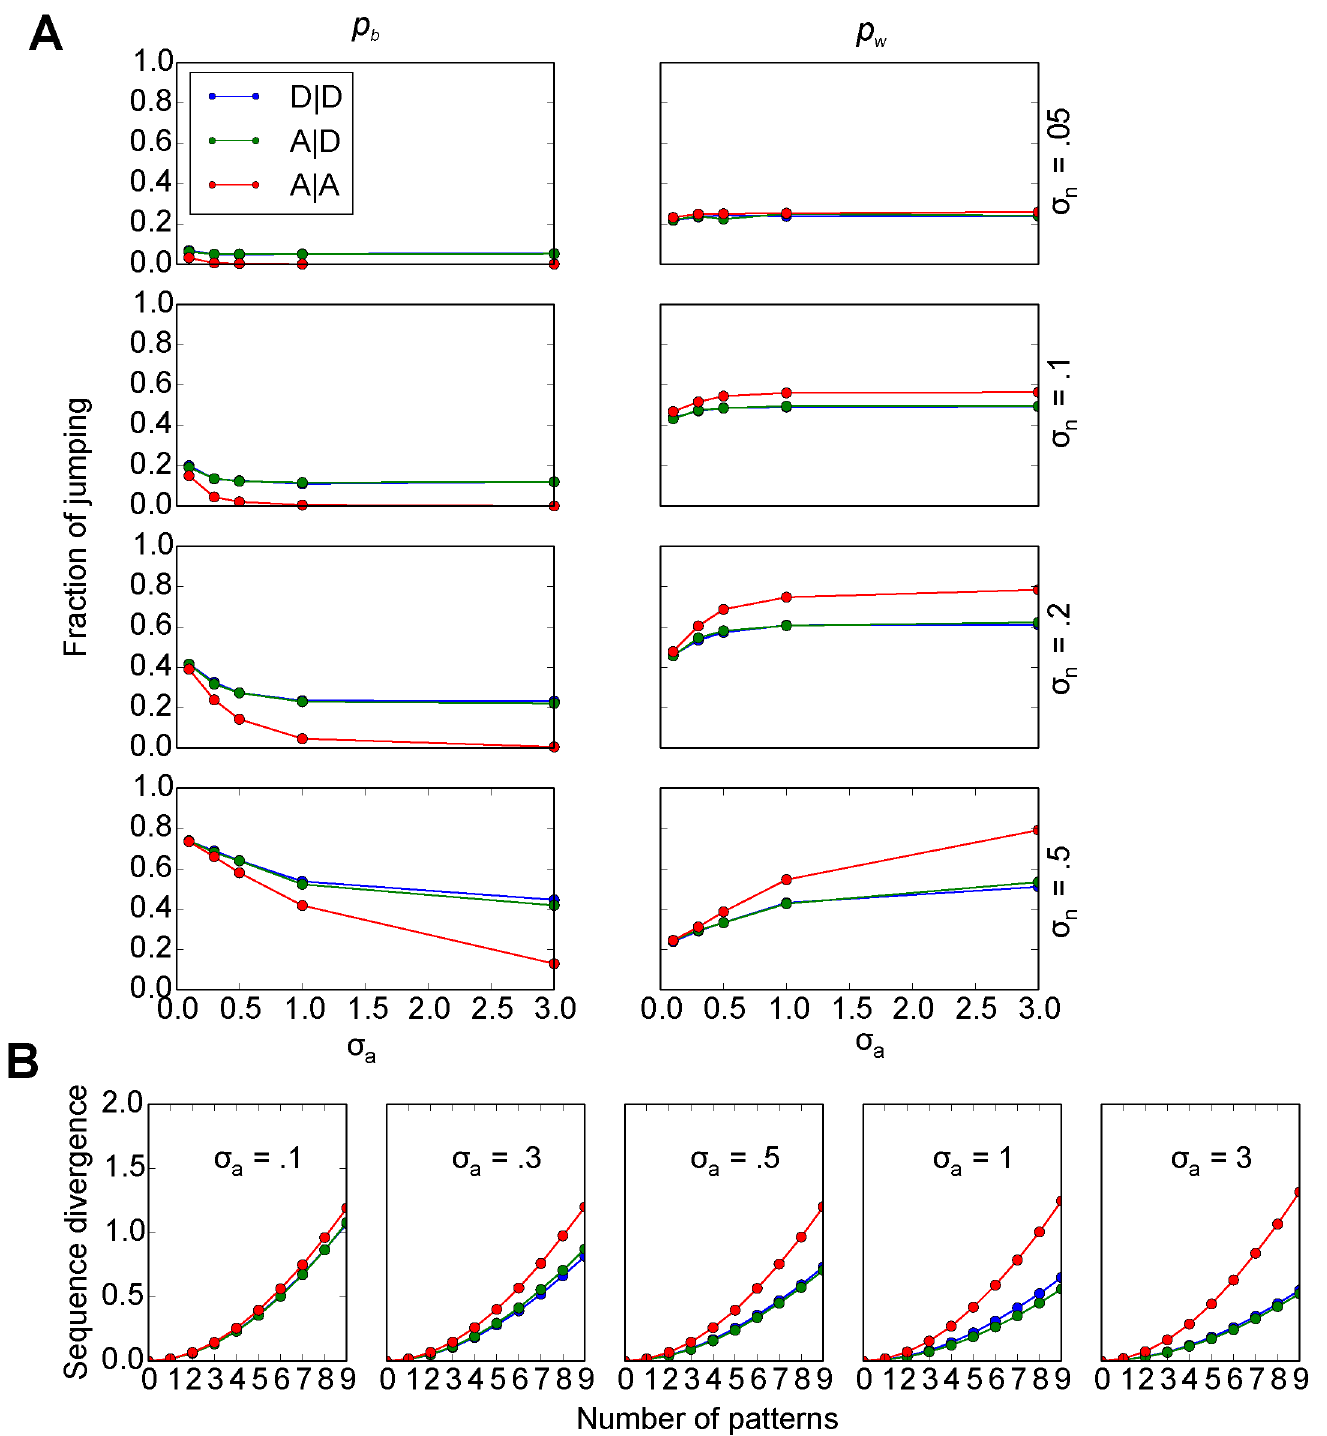
Fig 7. Probability of incorrect jumps and sequence divergence. A:left, probability of incorrect jumps between sequences ( p b ); right, probability of incorrect jumps within sequences ( p ). B: Sequence divergence. For A, B: a :2-D, k = 0.2, 200 stored sequences. w